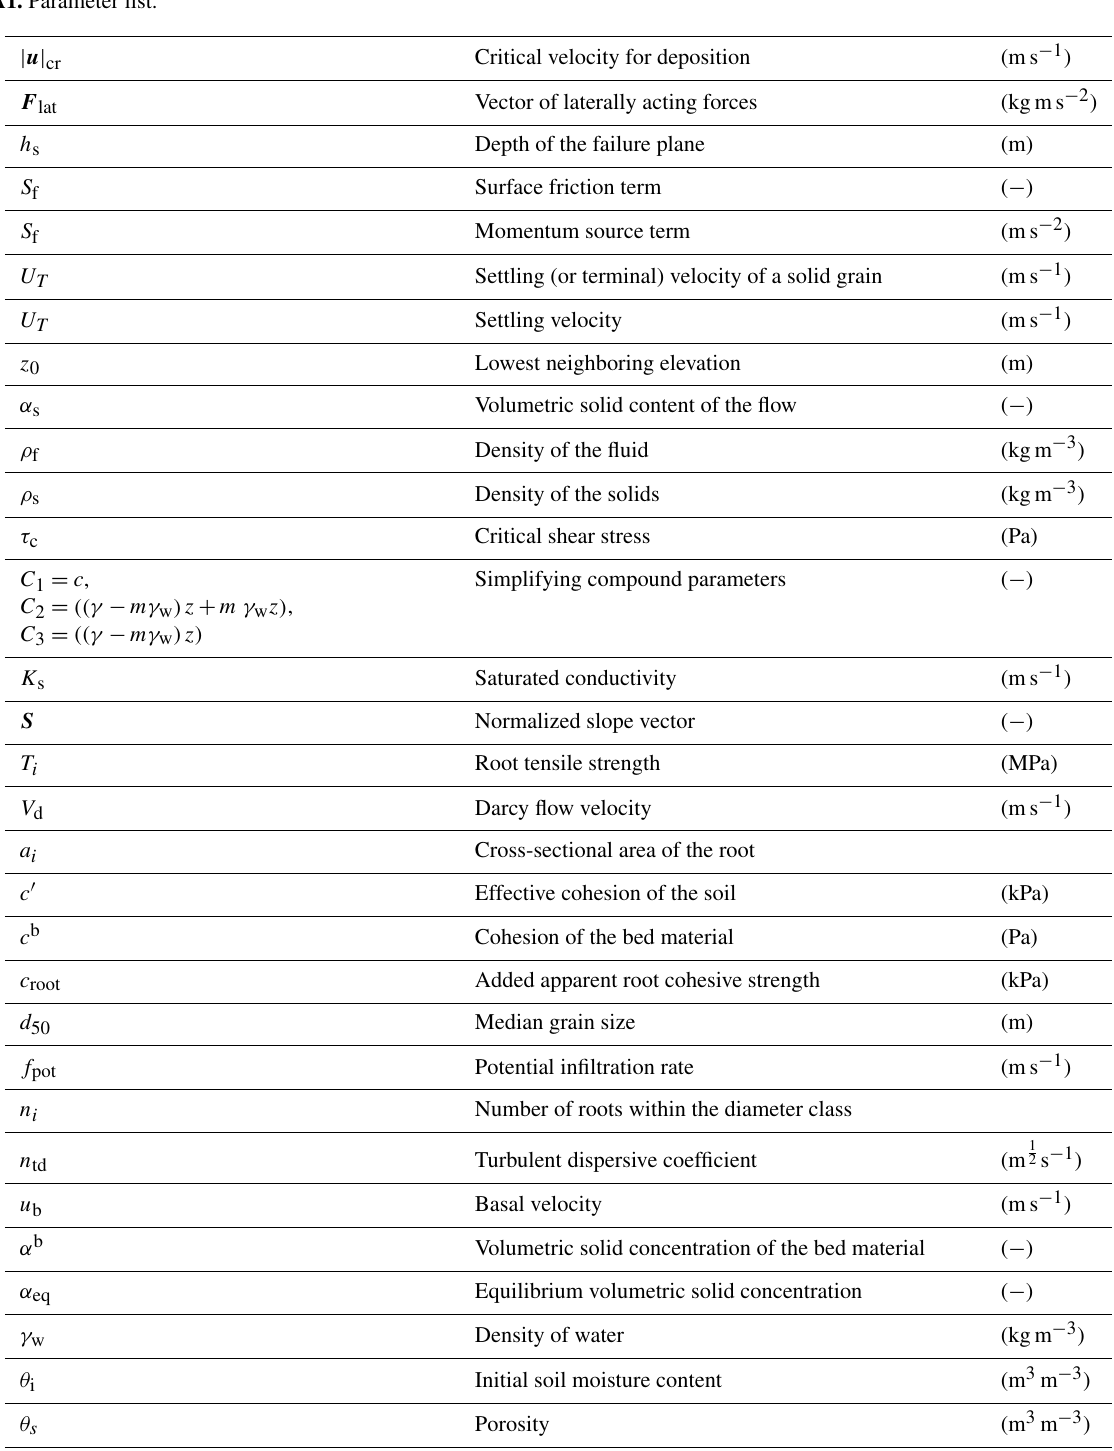
Table A1. Parameter